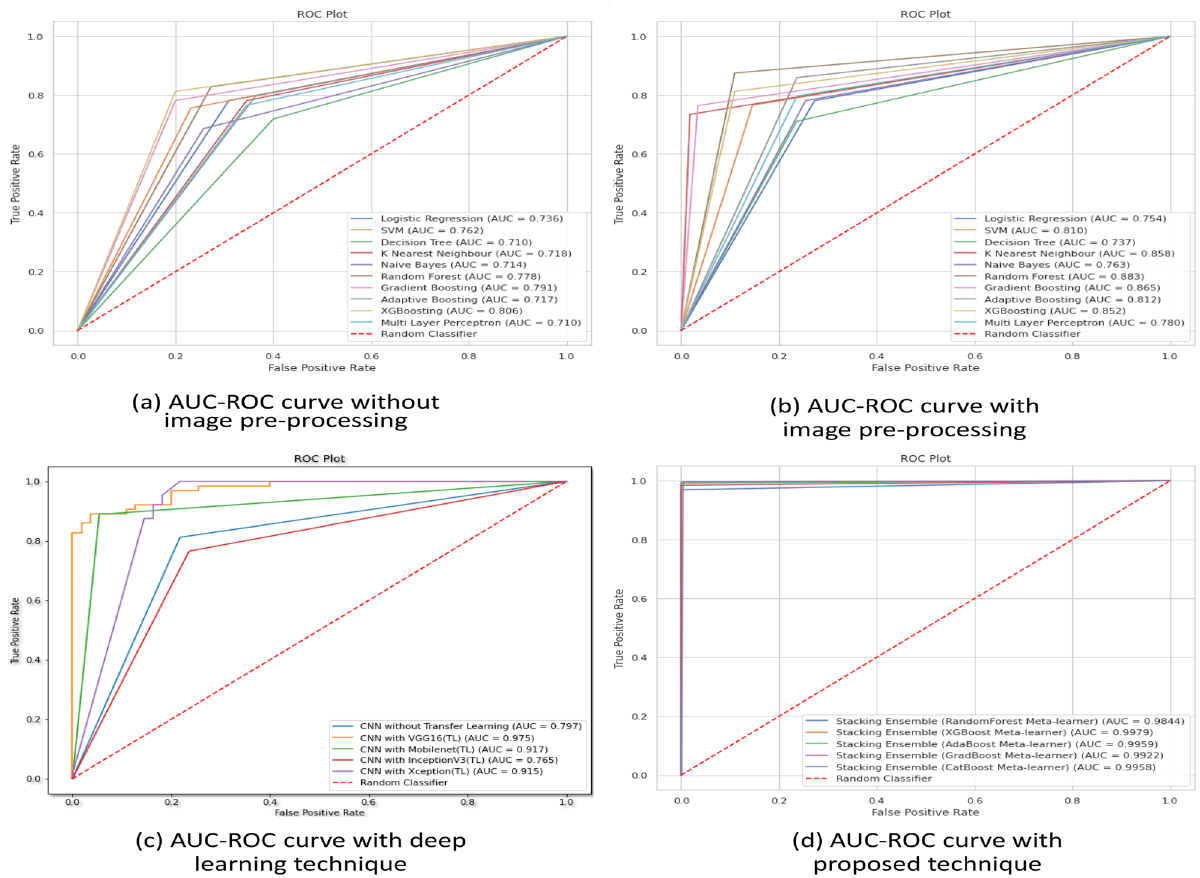
Figure 6. AUC-ROC curve for ML models ( a ) without image pre-processing (technique 1) ( b ) with image pre- processing (technique 1) ( c ) with deep learning (technique 3) ( d ) with proposed technique (technique